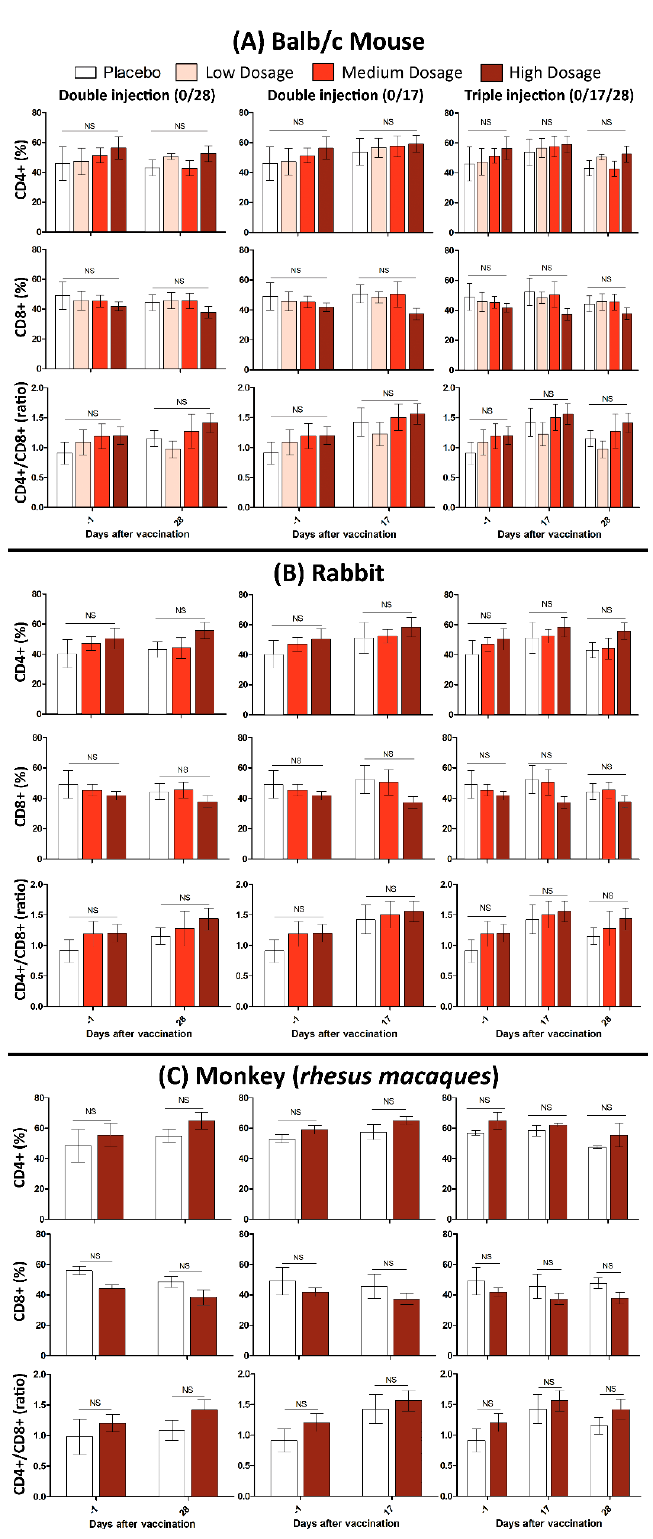
Figure 5. Cellular immunity evaluation after administration of low, medium, and high dosages of candidate vaccines in ( A ) Balb/c mice, ( B ) Rabbits, and ( C ) RMs. The error bars represent standard deviation of repeated experiments and “NS” at the top of bars indicates a non-significant difference between the averaged experiments.